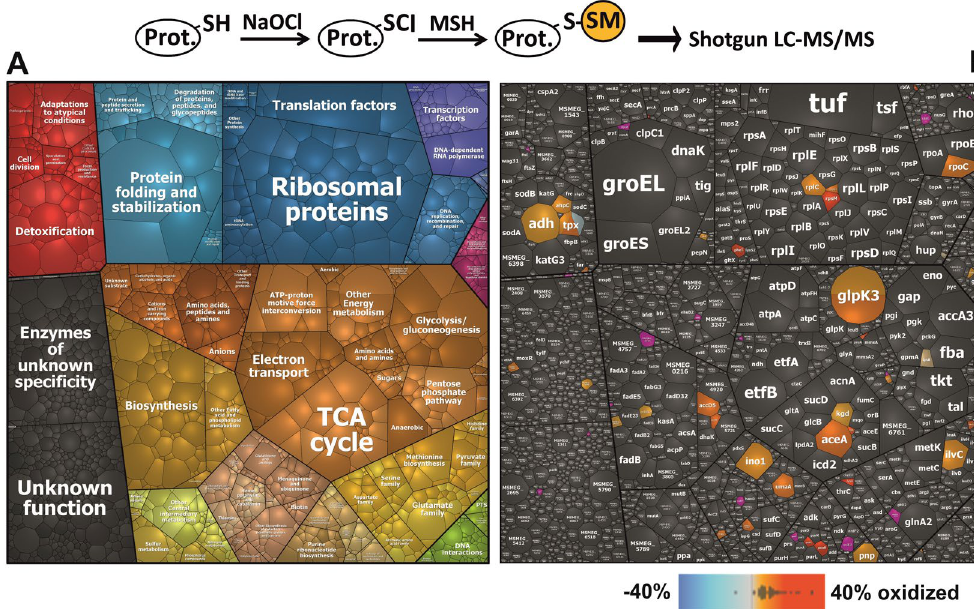
Figure 2. Voronoi treemaps show protein abundance of S -mycothiolated proteins identified in M. smegmatis under NaOCl stress using Orbitrap LC-MS/MS analysis. ( A ) The treemap legend shows the classification of the M . smegmatis proteome according to TIGRfam annotations. ( B ) The total spectral counts determine the cell size of each protein identified in the proteome dataset and classified according to TIGRfam. The identified 58 S- mycothiolated proteins are color-coded using an orange-red color gradient based on their Cys oxidation level as quantified by the OxICAT data (Tables 2, S3 and S4). Non-modified proteins are colored in grey and S- mycothiolated proteins that were not identified using the OxICAT approach are shown in